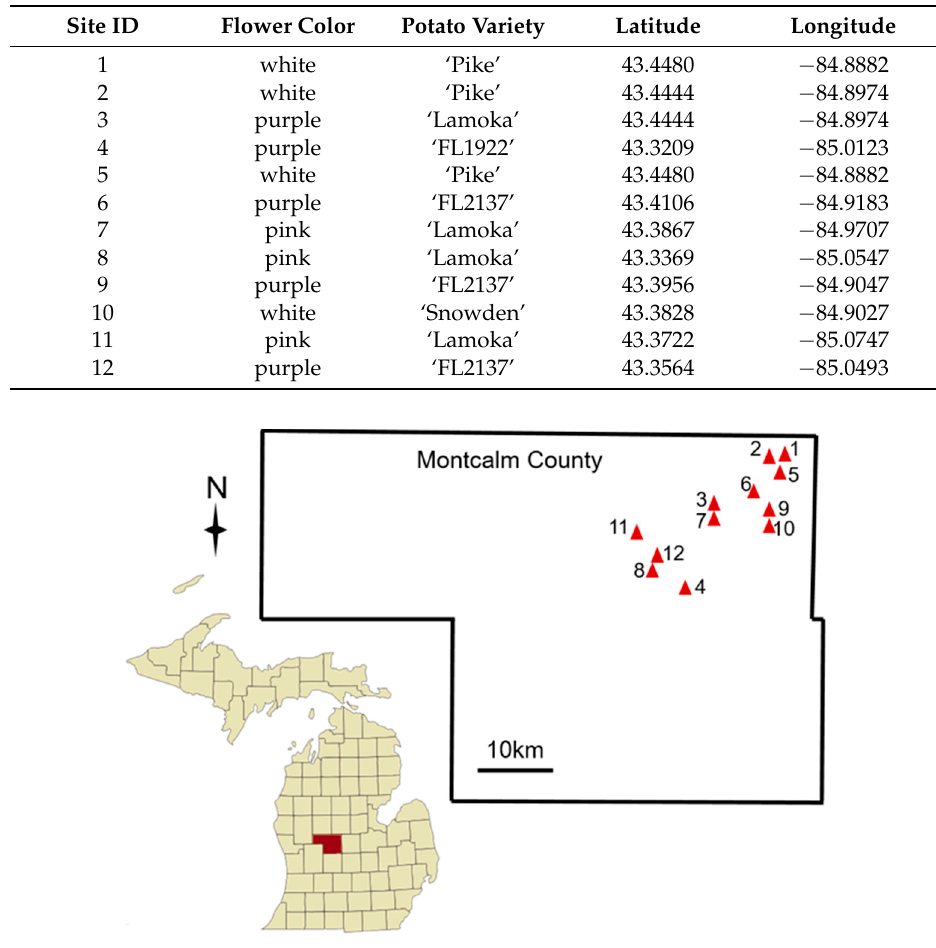
Figure 1. Commercial potato fields were surveyed for bees in Montcalm County (shown in red on the state map), Michigan, USA. Red triangles represent the locations of 12 commercial potato fields, which were used to survey bees. Fields were 0.8–18.2 km apart, with an average of 3.6 km distance between sites. Table 1. Site descriptions of commercial potato fields used for bee surveys in 2016. Bees were surveyed with four white, yellow, and blue bowls and four blue vane traps at each site.